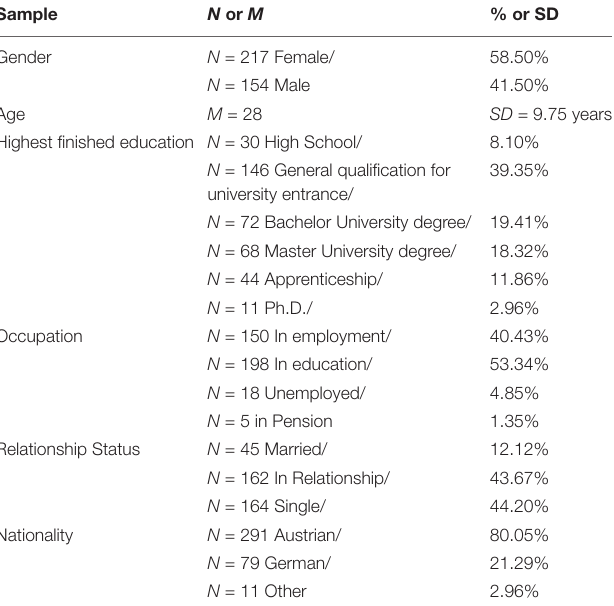
TABLE 1 | Sample characteristics ( N = 371).